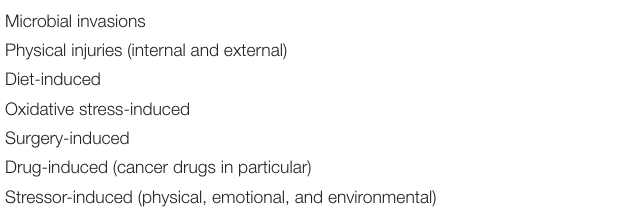
The Resolution Response is an evolutionarily conserved mechanism to protect the organism from unresolved injury-induced inflammation. Although microbial